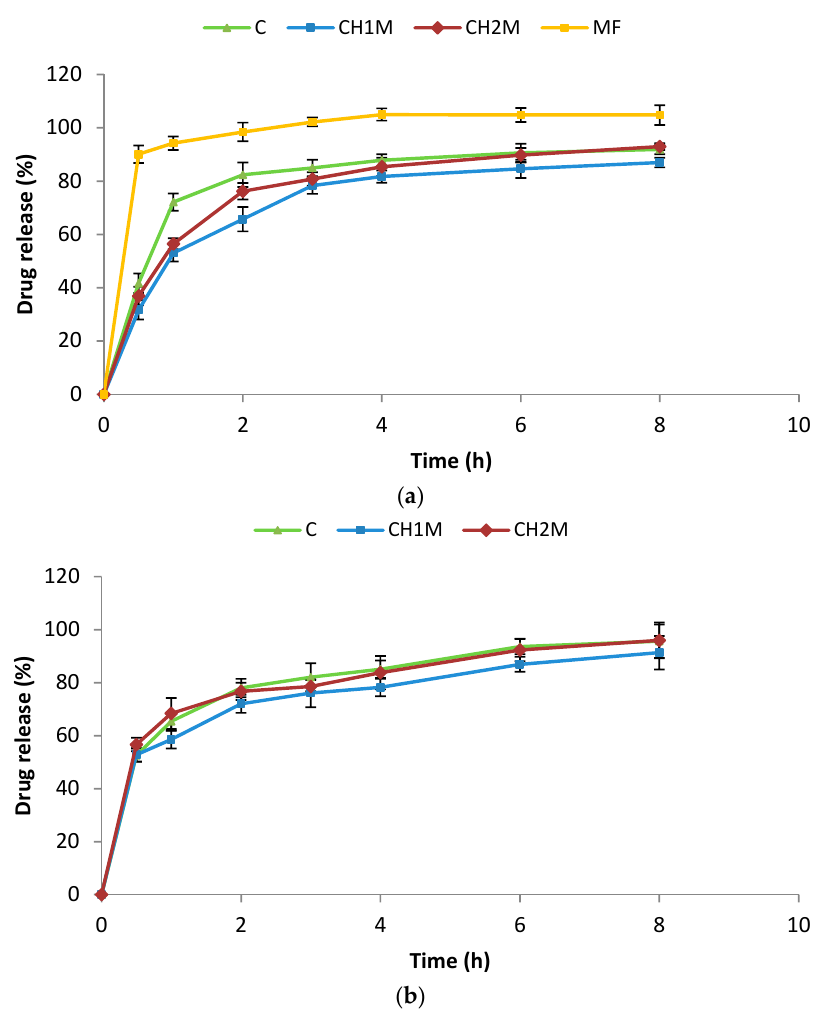
Figure 3. MF release from non cross-linked microparticles formulations C, cross-linked microparticles formulations CH1M, CH2M and non-modified commercially available tablet with metformin hydrochloride (MF): ( a ) after preparation; and ( b ) after six-month storage at 40 ± 2 °C and 75% ± 5% RH ( n = 3).